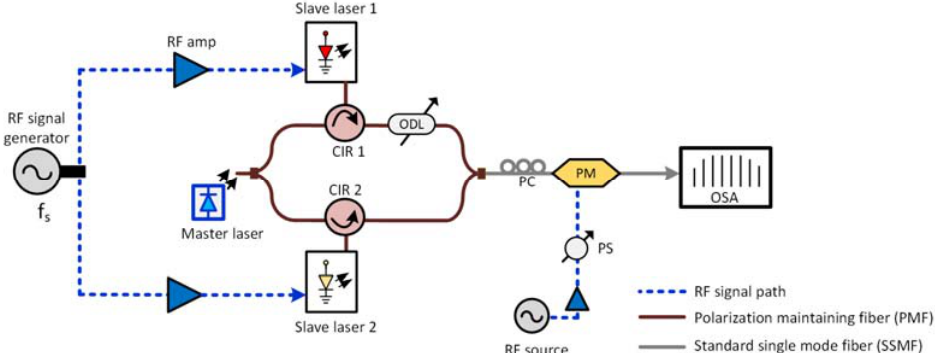
Figure 2. Experimental setup of the proposed MIL-GS OFC generation scheme. Here, RF sig.: radio frequency signal source; RF amp: amplifier; CIR: circulator; PS: phase shifter; ODL: optical delay line; PC: polarization controller; PM: phase modulator; f s : free spectral range (FSR); OSA: optical spectrum analyzer.